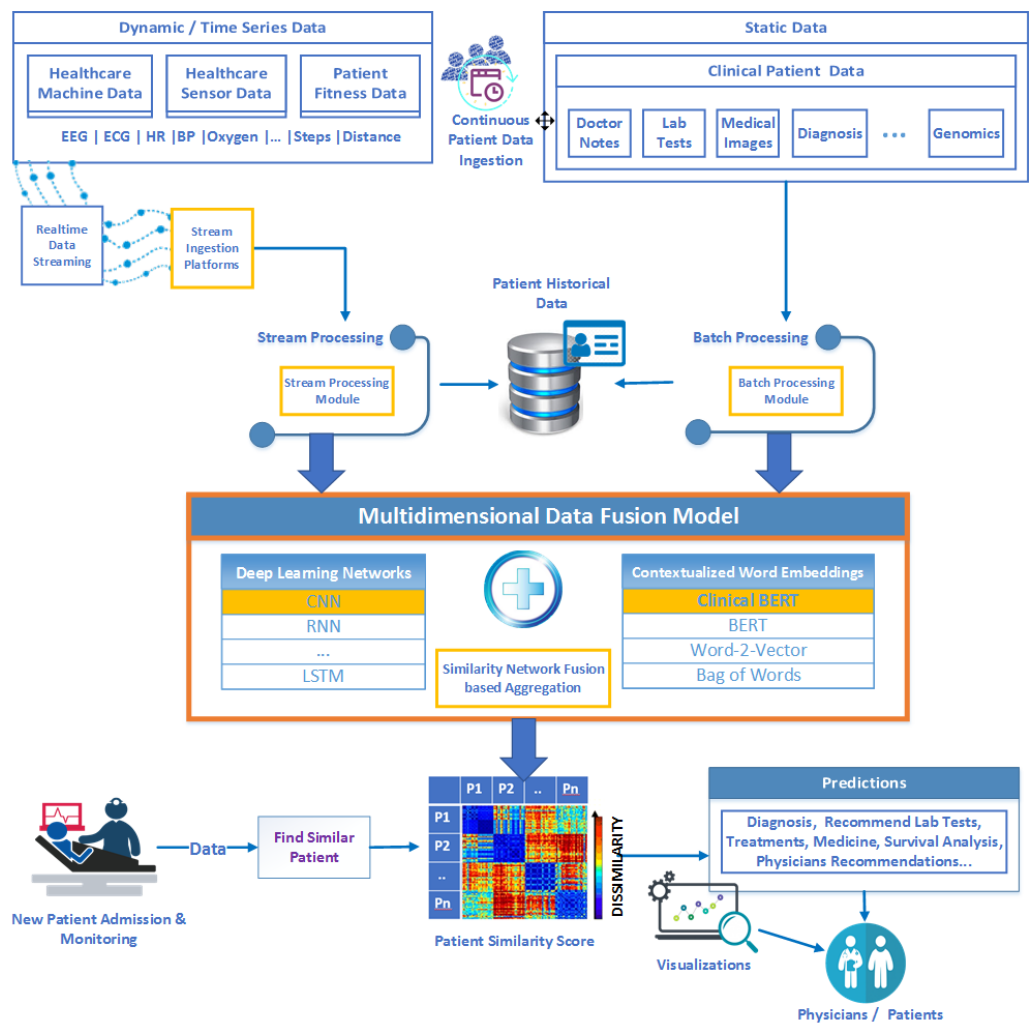
Figure 2. System